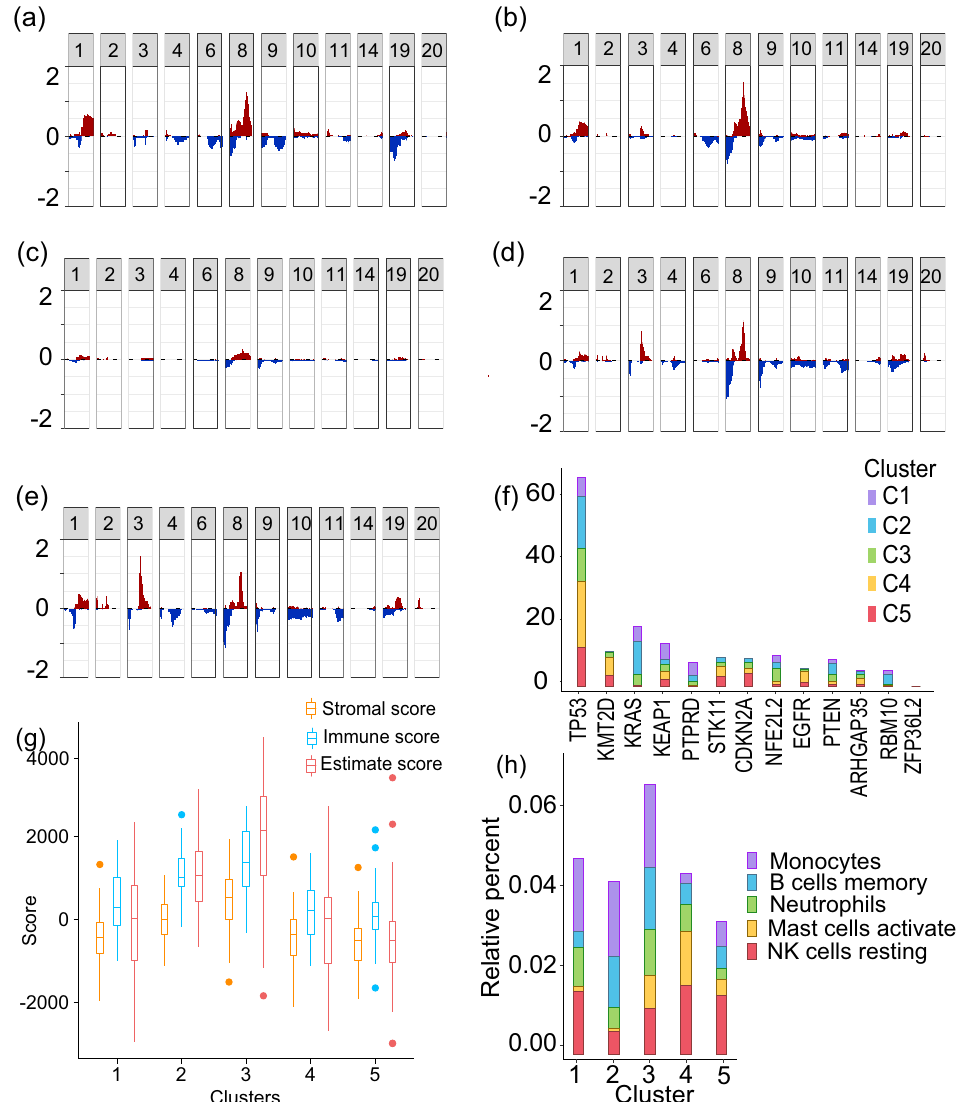
Figure 6. Molecular characters of samples with class labels obtained using methylation data. ( a )–( e ) Frequency plots for copy number variation corresponding to clusters 1–5 (y-axis: proportion of copy number gain/loss, x-axis: Chromosome number) and ( f ) Mutation of driver genes in the subgroups. ( g ) Box plot showing the distribution of stromal, immune, and ESTIMATE scores in each subgroup. ( h ) Bar plot showing the distribution of significantly enriched immune cell types in the